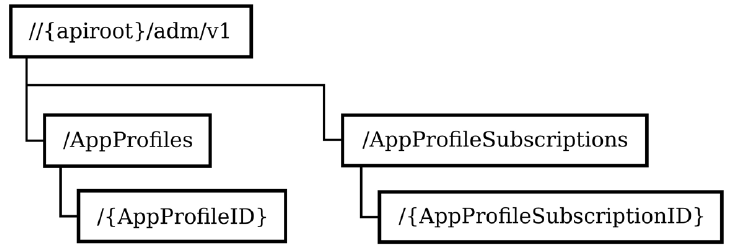
Figure 4. Structure of the URIs of the ADM service resources.